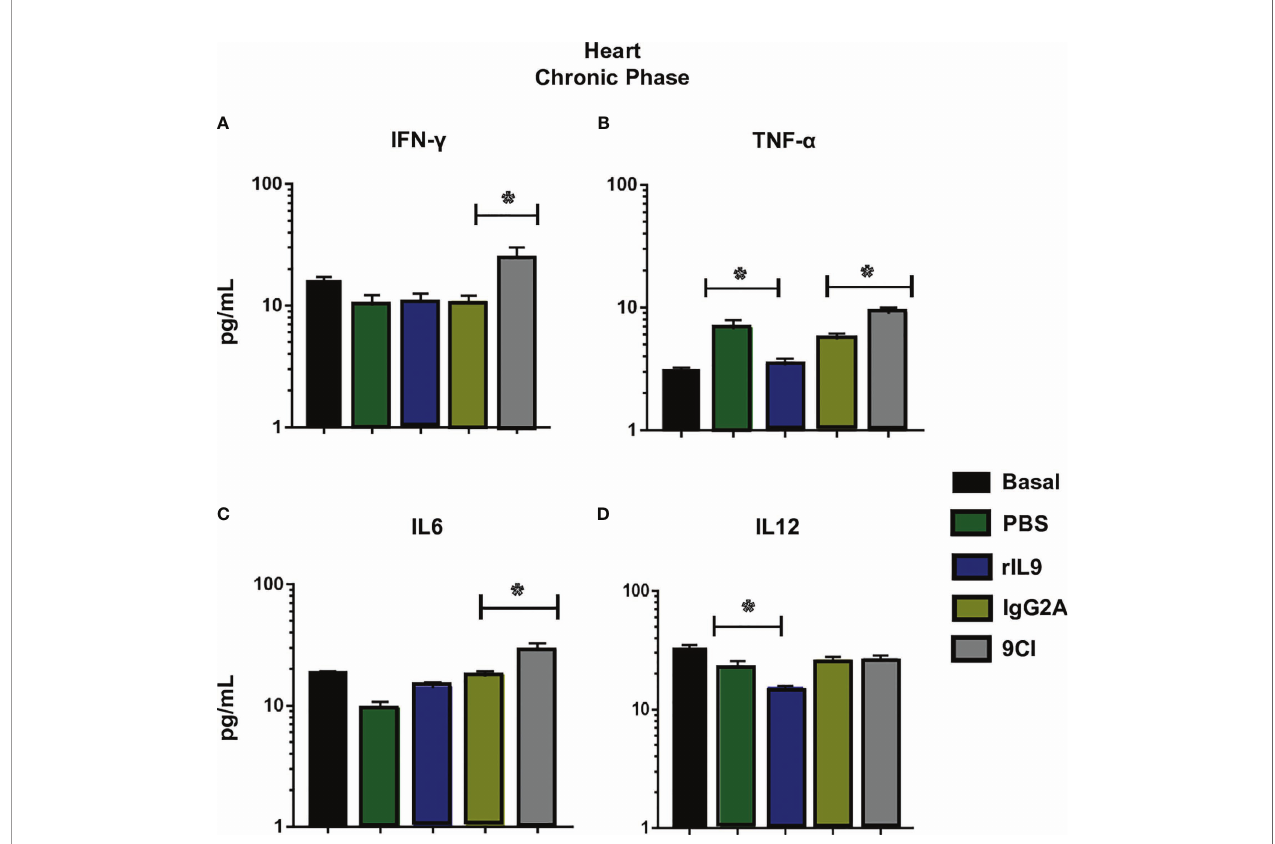
FIGURE 7 | Cytokine levels in heart lysates from infected BALB/c mice, those treated with 9CI or rIL9, and the respective controls. Cytokines were quanti fi ed in heart lysates (40 m g of protein) from infected mice, those treated with 9CI or rIL9, and control mice (IgG2a and PBS, respectively) after 60 dpi (chronic phase). IL-9 neutralization stimulated IFN- g (A) , TNF- a (B) , and IL-6 (C) synthesis during chronic infection. rIL9 treatment reduced IL-12 (D) production Anova test *p < 0.001. Basal: uninfected and untreated